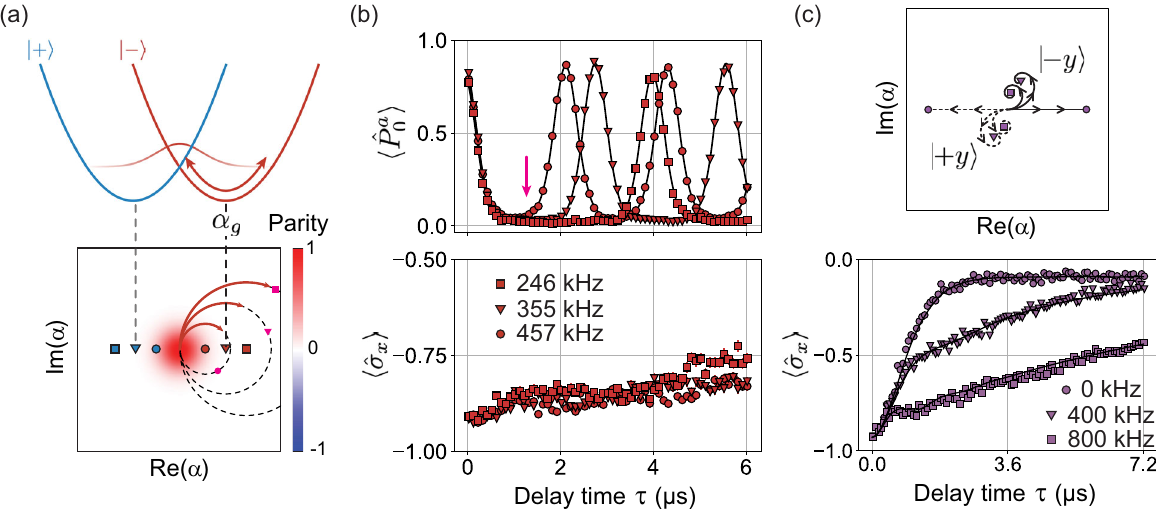
FIG. 2. Calibrating coherent and dissipative conditional displacement interactions on the tuning mode (a),(b) and the coupling mode ˆ H (c). (a) Depiction of tuning mode dynamics under . The oscillator ’ s equilibrium position shifts by þ α when the qubit is in j − i (red) a g and − α when the qubit is in jþi (blue). Top: an initial wave packet j − i ⊗ j α ¼ 0 i oscillates along the red potential surface associated g a with j − i . Bottom: in phase space, the state performs a circular trajectory around the equilibrium location, indicated by the red triangle for the top schematic. Smaller and larger equilibrium positions are indicated by the circle and square, respectively. (b) Coherent state ˆ H revivals during evolution under . We prepare an initial state j − i ⊗ j α ¼ 0 i and simultaneously measure the vacuum projector of the a a ˆ P a 0 i tuning mode (top) and ˆ σ (bottom) for different calibrated values of Δ . Solid lines are fits to a simple analytic model, h 0 j 0 ¼ j x a a a = 2 π ¼ 450 kHz and Δ = 2 π ¼ 457 kHz (circles), 355 kHz (triangles), and 246 kHz (squares) which determine the extracting values g x a values of α . Approximate locations of the coherent state for each calibration at a delay time marked by the magenta arrow are shown in g the bottom panel of (a). At the same time, the qubit largely remains in j − i up to intrinsic decoherence. (c) Top: coupling mode state trajectories starting in vacuum j 0 i for various values of Δ (rates from the bottom panel) with fixed values of ˆ g and κ , splitting in b b b b phase space depending on if the qubit is in j(cid:2) y i . Full coherent state distributions are not depicted because we are in the weak measurement regime where there is significant overlap between the coherent states. Bottom: measurement-induced dephasing of j − i = 2 π ≈ 117 kHz, Δ = 2 π ≈ f 0 ð circles Þ ; 400 ð triangles Þ ; 800 ð squares Þg kHz and κ = 2 π ≈ 320 kHz obtained from independent with g y b b calibrations. Solid lines represent equivalent time-domain master equation simulation results (see Appendix F). All error bars indicate standard deviations and may not be visible compared to marker